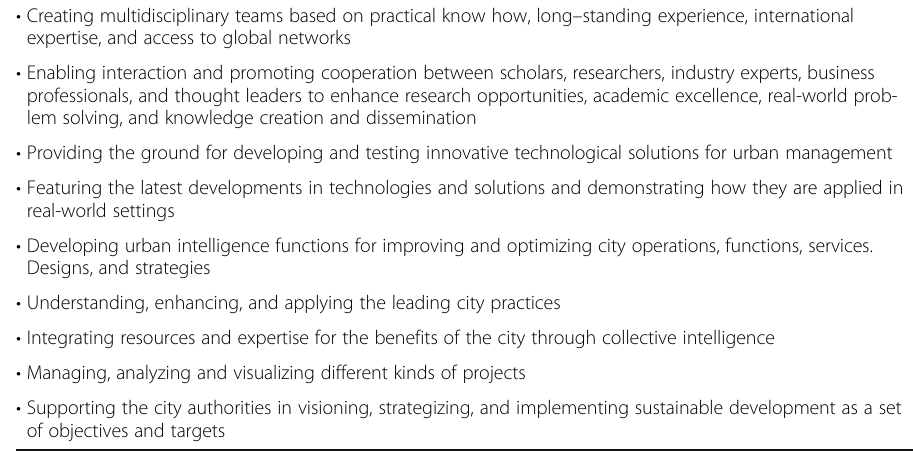
Table 11 The key functions of innovation and research centers (cid:129) Creating multidisciplinary teams based on practical know how, long – standing experience, international expertise, and access to global networks (cid:129) Enabling interaction and promoting cooperation between scholars, researchers, industry experts, business professionals, and thought leaders to enhance research opportunities, academic excellence, real-world prob- lem solving, and knowledge creation and dissemination (cid:129) Providing the ground for developing and testing innovative technological solutions for urban management (cid:129) Featuring the latest developments in technologies and solutions and demonstrating how they are applied in real-world settings (cid:129) Developing urban intelligence functions for improving and optimizing city operations, functions, services. Designs, and strategies (cid:129) Understanding, enhancing, and applying the leading city practices (cid:129) Integrating resources and expertise for the benefits of the city through collective intelligence (cid:129) Managing, analyzing and visualizing different kinds of projects (cid:129) Supporting the city authorities in visioning, strategizing, and implementing sustainable development as a set of objectives and targets